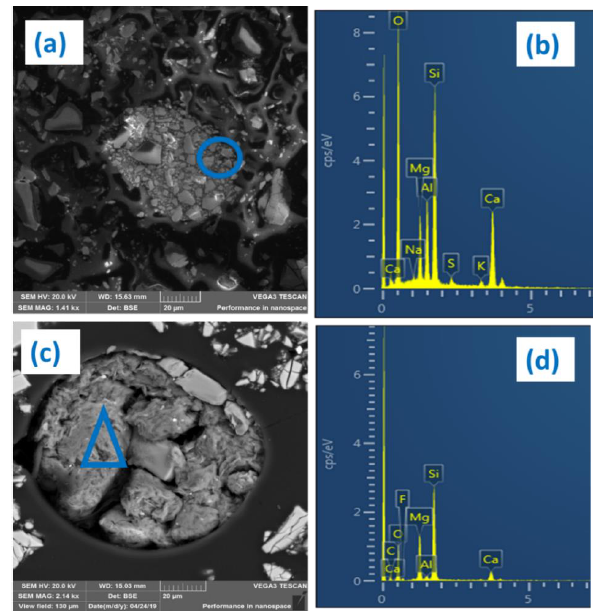
Figure 9. SEM–EDS of GGBS before and after reaction with acid mine drainage: ( a ) micrograph of unreacted GGBS, ( b ) EDS spectra taken at a point selected with a circle in ( a ), ( c ) micrograph of reacted GGBS, ( d ) EDS spectra taken at a point selected with a triangle in ( c ).